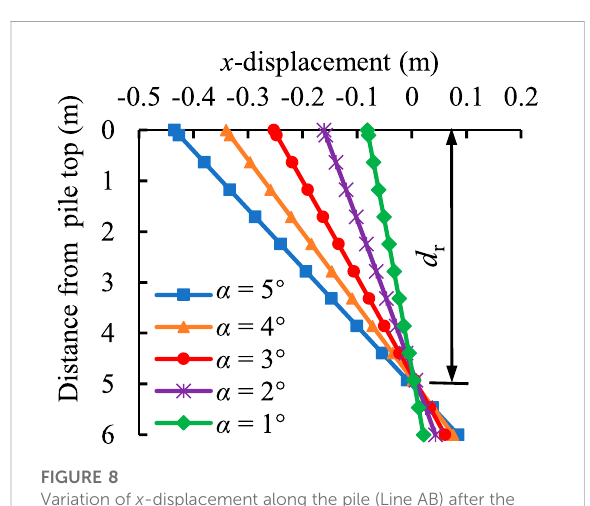
FIGURE 8 Variation of x -displacement along the pile (Line AB) after the deviation recti fi cation of inclined piles at different values of pile inclination angle α